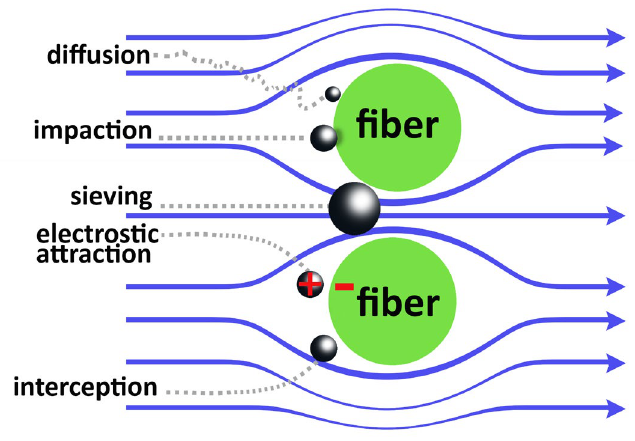
Figure 1. Capture mechanisms involved in air filtration.